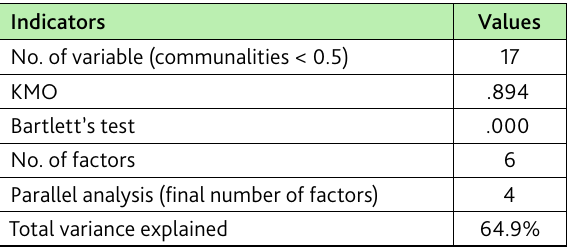
Table 1. PCA indicators for Italy